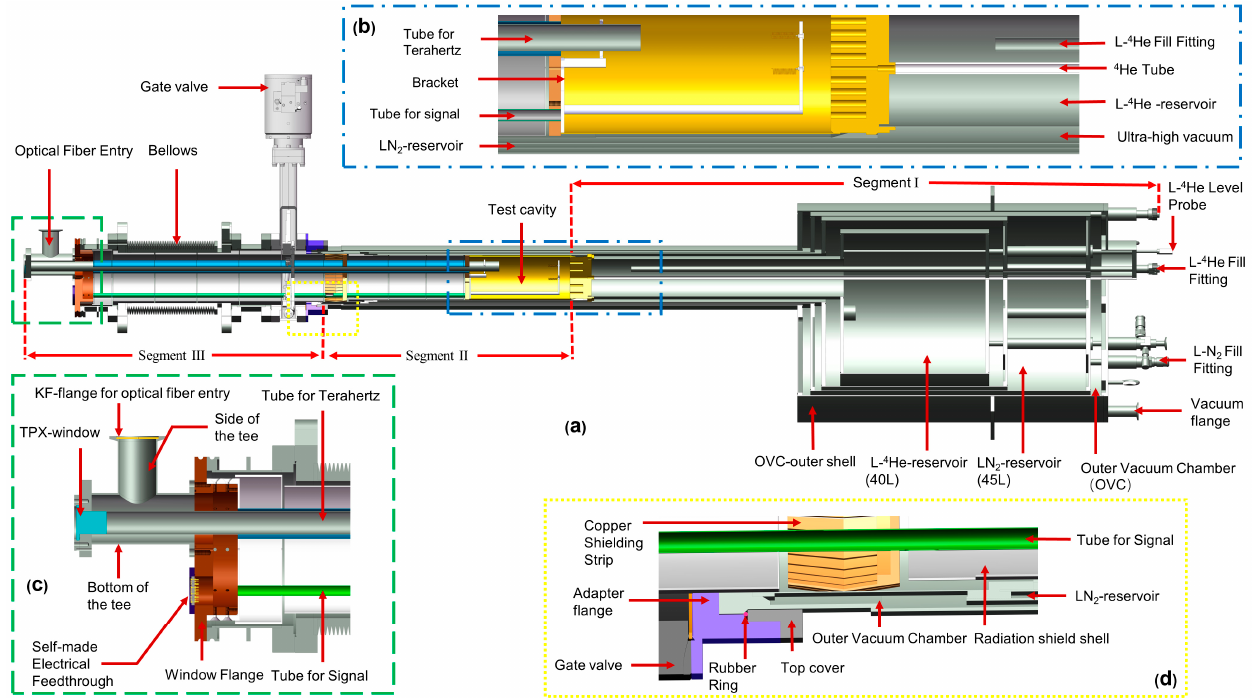
Figure 1. ( a ) Three-dimensional cross-section of the cryostat designed for LD-SPM. ( b ) Enlarged view of the test cavity. ( c ) Enlarged view of the window flange. ( d ) Enlarged view of the bottom of the liquid nitrogen reservoir.